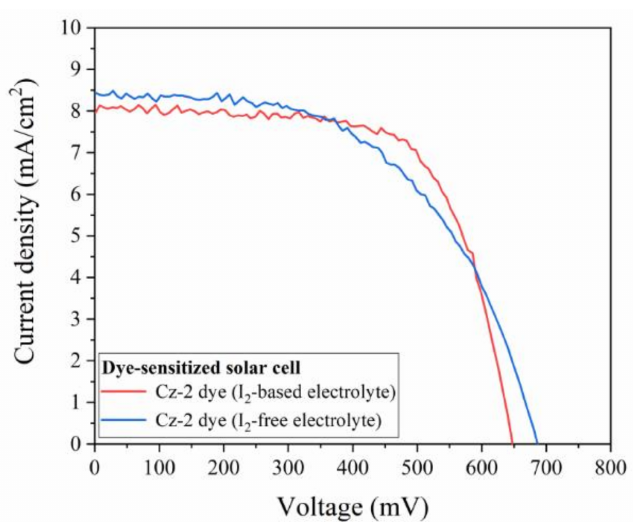
Figure 6. J-V characteristic curves of the solar cells that employed the working electrodes that were sensitized by the Cz-2 dye, using the I 2 -based or I 2 -free electrolyte. Table 2. Electrical characteristics of the solar cells that employed the working electrodes that were sensitized by the Cz-2 dye, using the I 2 -based or I 2 -free electrolyte. Solar Cell J SC V OC FF ECE (%)Dye Electrolyte (mA/cm 2 ) (mV) ( − ) Cz-2 I 2 -based 8.02 ± 0.05 648 ± 5 0.68 ± 0.02 3.51 ± 0.05 Cz-2 I 2 -free 8.50 ± 0.32 685 ± 5 0.54 ± 0.03 3.13 ±